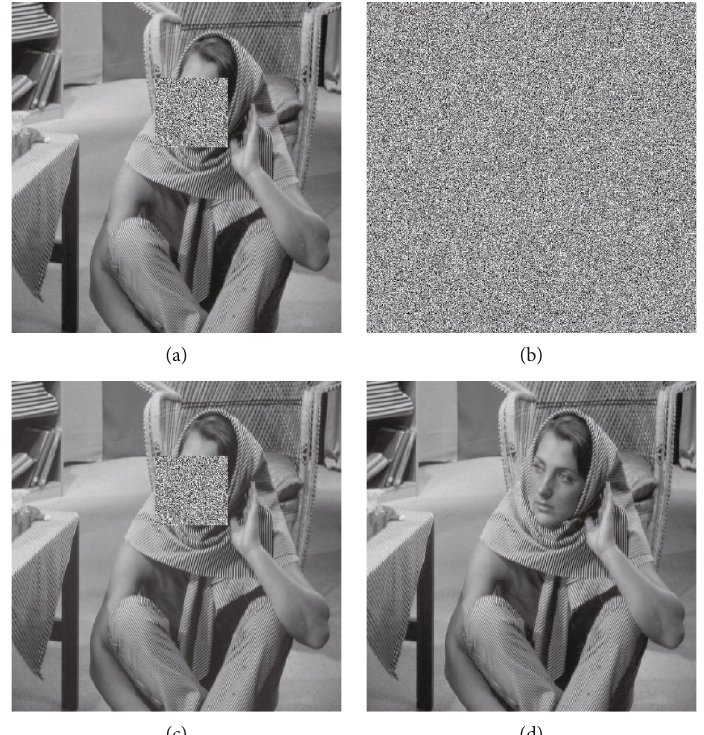
Figure 5: Visualization for Barbara. (a) First encryption. (b) Second encryption. (c) Decrypt for the fi rst time. (d) Decrypt for the second